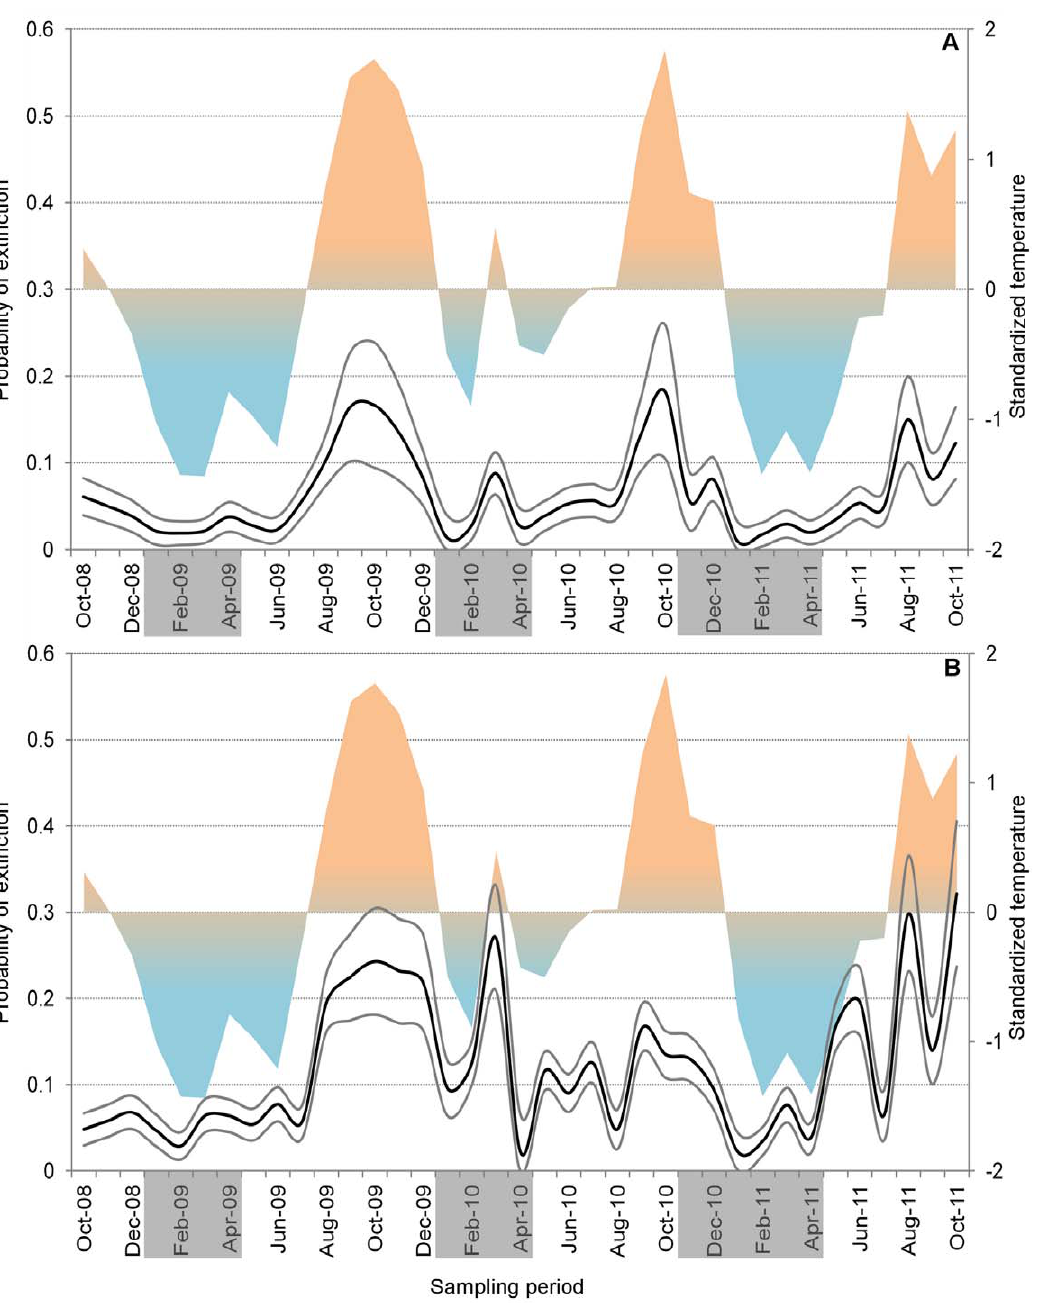
Figure 5. Derived estimates of local extinction probabilities ( e ) for Aedesaegypti (A) and Ae.albopictus (B). For each species, e estimates (bold black lines) and 95% confidence intervals (thin grey lines) were derived from the best-performing (lowest AICc) 38-month model. We also plot variation ( z -scores) of average maximum temperatures during sampling days and the previous two weeks (t max -2-week-lag , right y axes in each panel; colored areas); this was the meteorological covariate in the best Aedes aegypti model. On the x axis, grey boxes highlight the periods in which city- wide, massive Aedes control campaigns, called Operac¸a˜o Impacto [29,30], took place; note that they coincide with months of very low e values. doi:10.1371/journal.pone.0058420.g005 with the maximum value estimated for October 2011 (Figure 5B). Mean dwelling colonization probability was estimated as c = 0.59 (95% confidence interval 0.51–0.66).